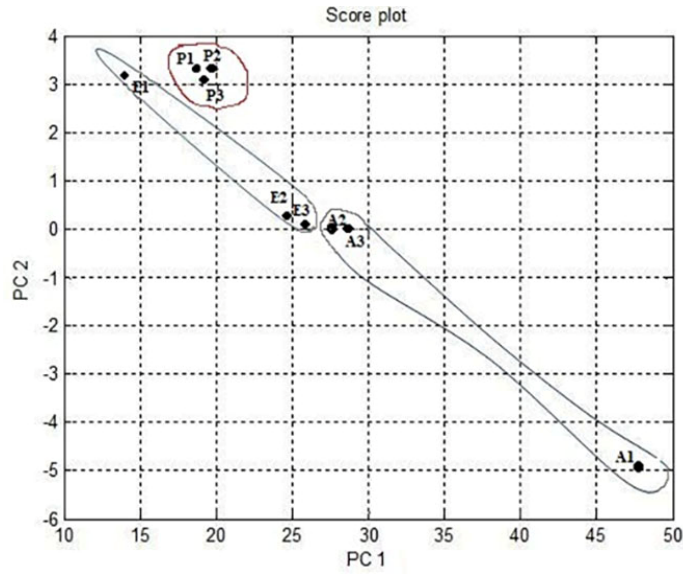
Figure 11. Multivariate technique on organic gases relative feature notch design.